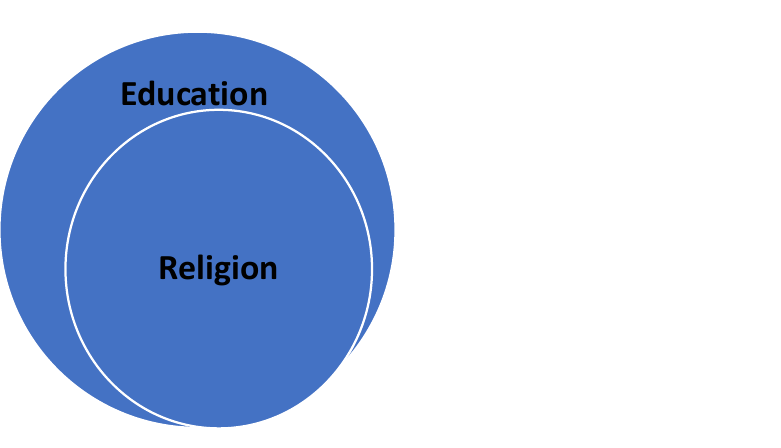
Figure 3. Education from religion and the liberal purpose of religious.